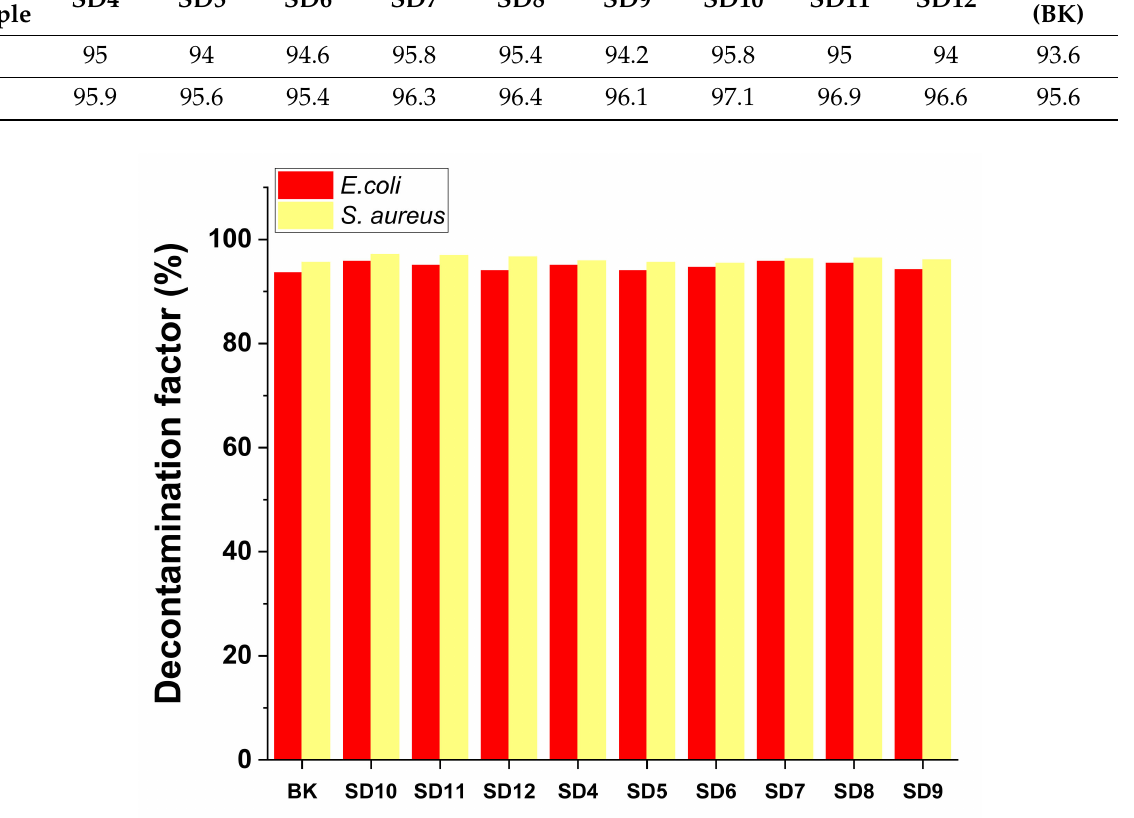
Figure 9. Biological decontamination